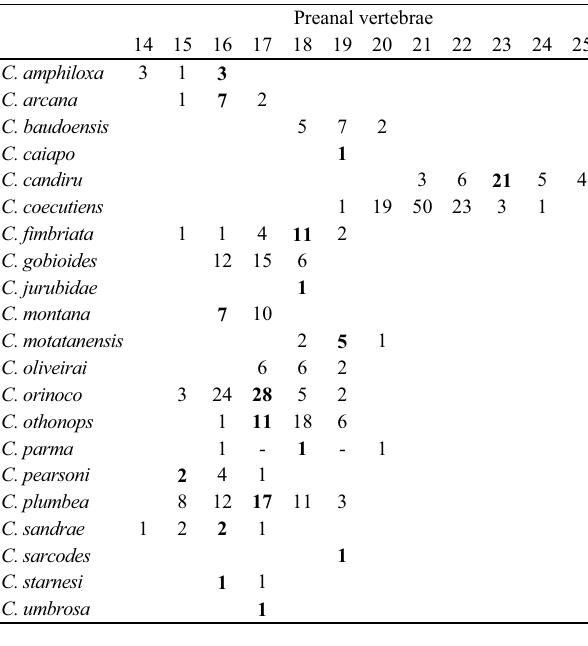
Table 12. Number of specimens of the species of Cetopsis with cited number of preanal vertebrae. Bold indicates value for holotype or lectotype when examined.